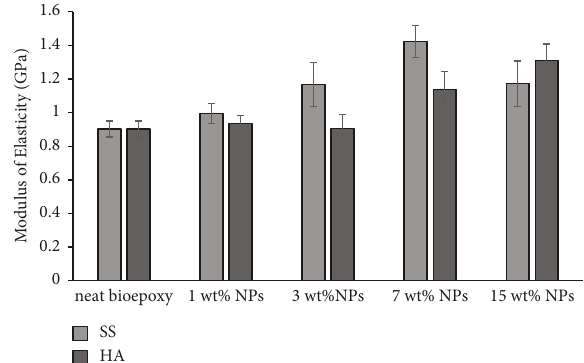
Figure 5: Impact of the incorporation of different mass fractions of HA or SS nanoparticles on the modulus of elasticity of bioepoxy.